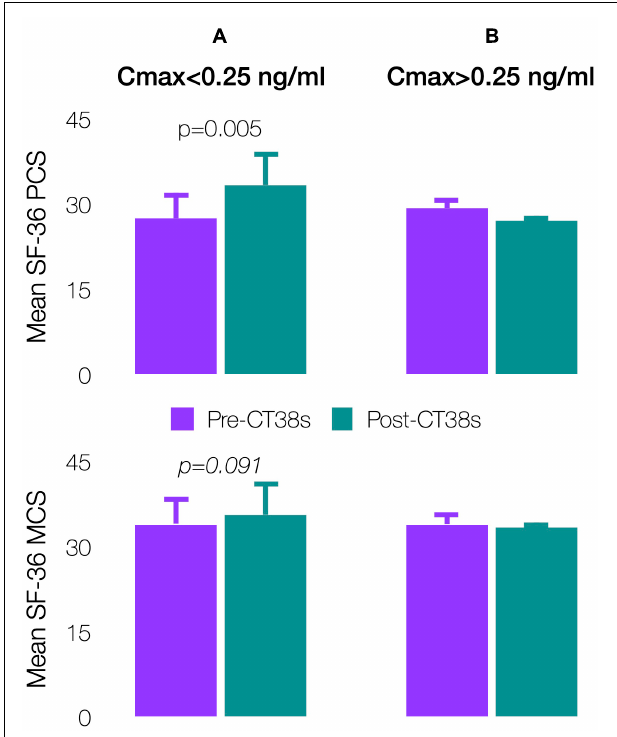
FIGURE 8 | Effect of CT38 on the means of pre-treatment (purple bars) and post-treatment (green bars), with standard deviations (error bars), of SF-36 physical component score (PCS) and SF-36 mental component score (MCS) for CT38: (A) Cmax < 0.25 ng/ml; and (B) Cmax > 0.25